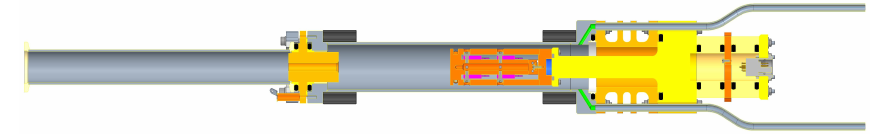
Figure 3. Extended gas target chamber and a top view of beam calorimeter are shown. Two grey pipes at the right side of the figure, to inlet the gas inside the chamber.